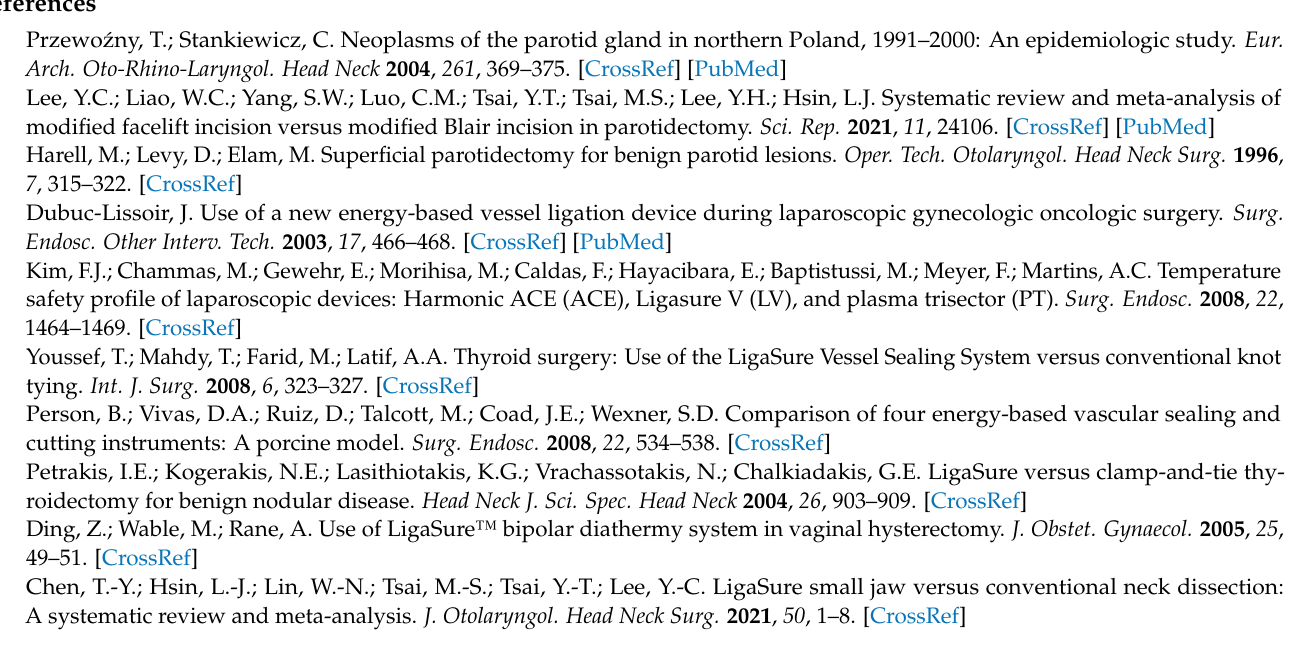
Table S2: Newcastle–Ottawa Scale Quality Assessment of Included Nonrandomized Studies; Table S3: Risk of Bias Assessment of Included Randomized Studies; Table S4: PRISMA checklist; Table S5: Funnel plots; Figure S1: Forest Plots of Studies of Superficial Parotidectomy; Figure S2: Forest Plots of Studies of Observational